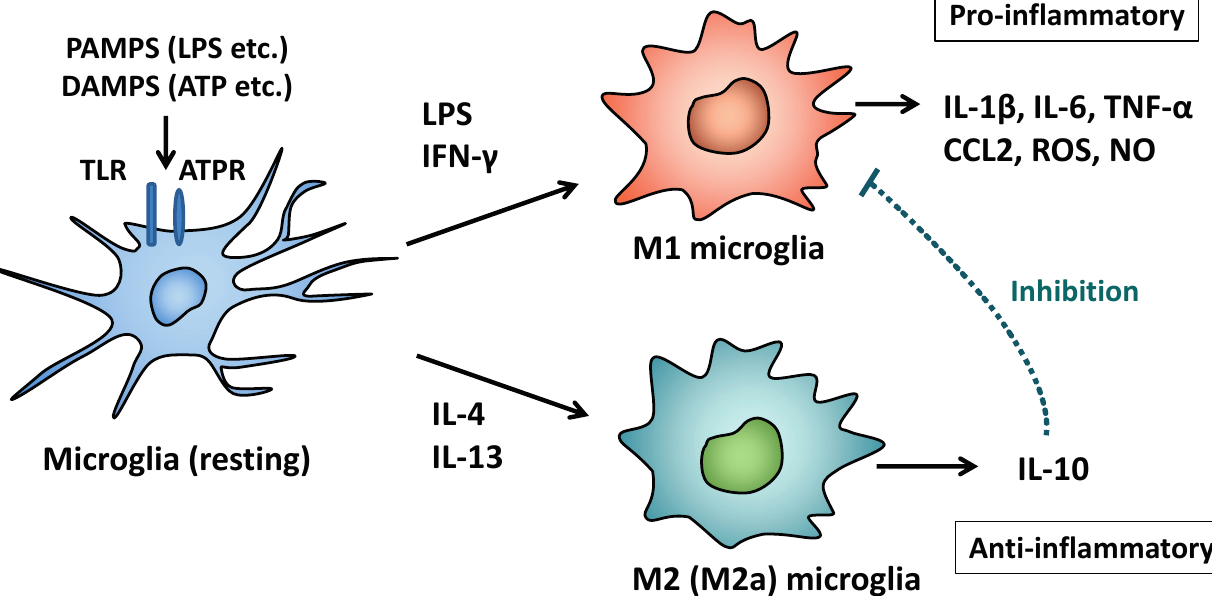
Figure 1. M1/M2 polarization of microglia and their immunoregulatory functions. Resting microglial cells are stimulated with PAMPS or DAMPS via TLR or ATP receptors. In the presence of LPS and IFN- γ , microglial cells polarize to M1 phenotype and produce pro-inflammatory cytokines/mediators including IL-1 β , IL-6, TNF- α , CCL2, ROS, and NO. In contrast, IL-4 and IL-13 induce alternative activation of microglia to M2 (‘M2a’) phenotype which down-regulates M1 functions by anti-inflammatory cytokine, IL-10.